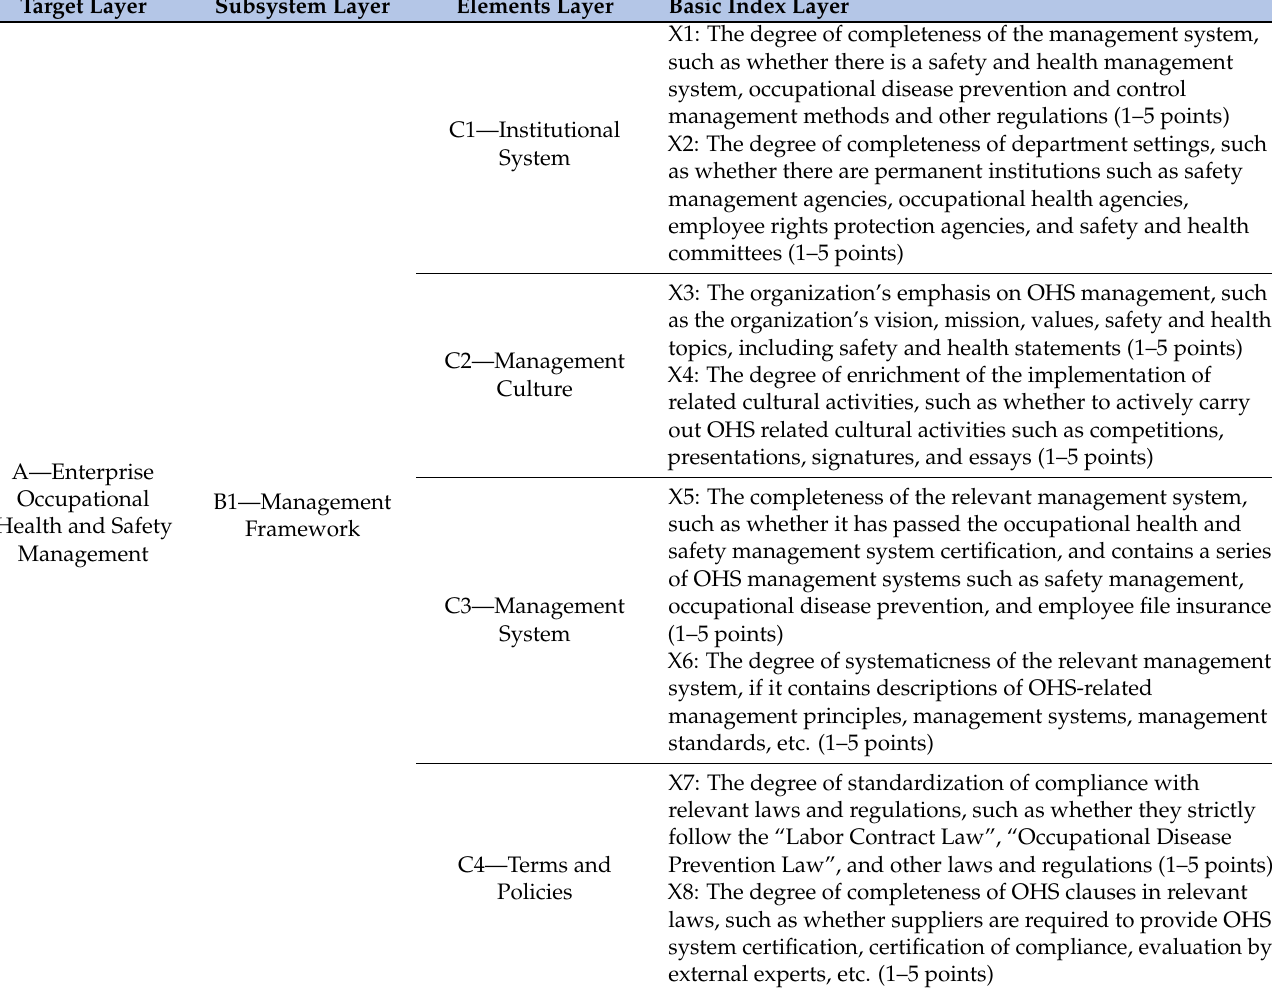
Table 1. Enterprise occupational health and safety management evaluation index